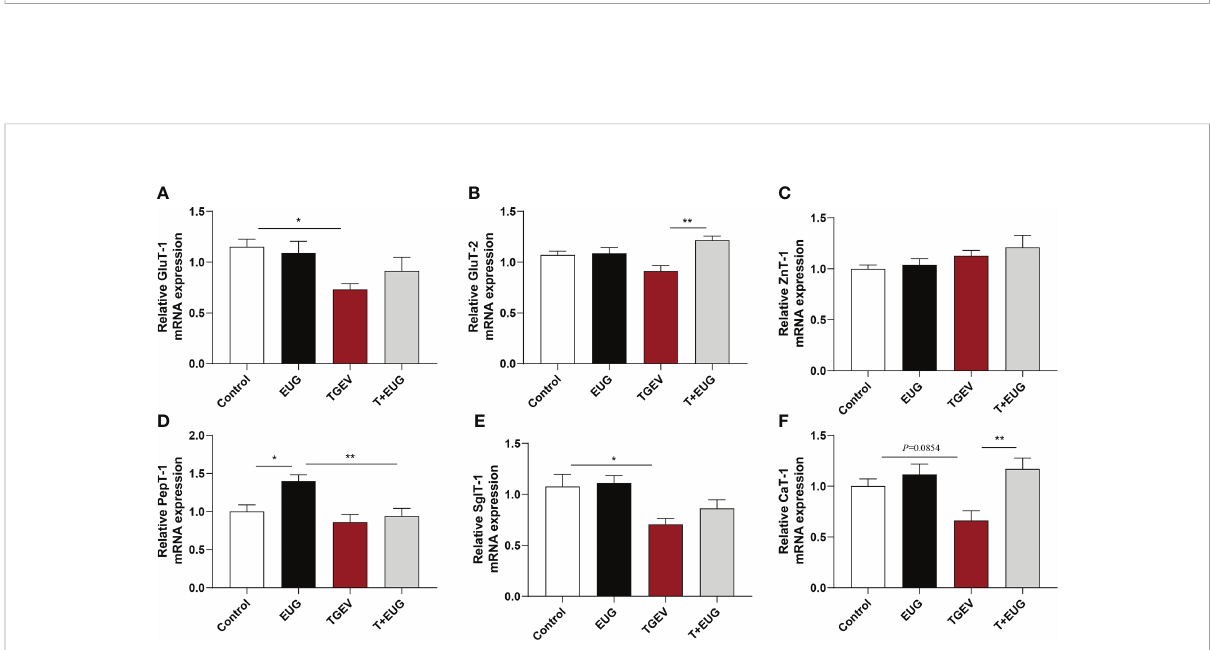
FIGURE 8 Effects of eugenol on jejunum transporte related genes expression levels in TGEV-infected weaned piglets. (A-F) Levels of GluT-1 , GluT-2 , ZnT-1 , PepT-1 , SglT-1 and CaT-1 mRNA in the jejunum mucosa was examined by RT-PCR. Data were expressed as mean ± SEM. * p < 0.05, ** p <